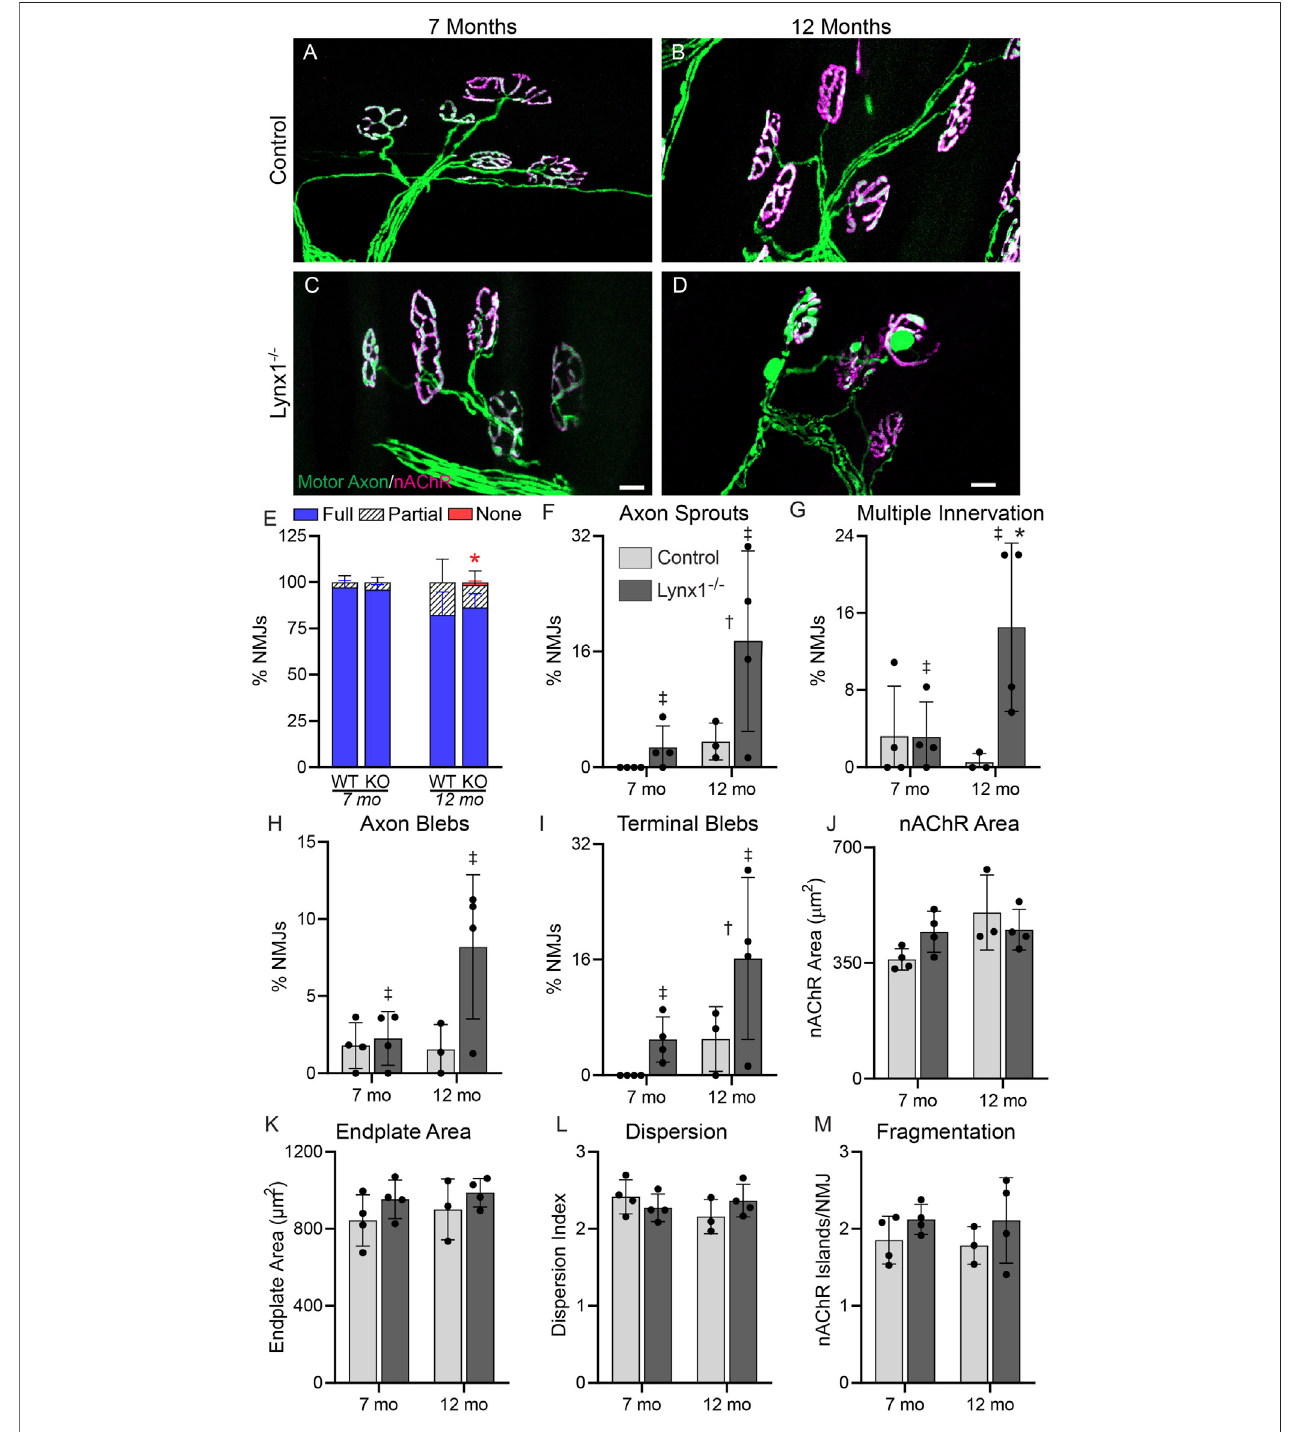
FIGURE 6 | Lynx1 deletion increases the incidence of age-related changes at adult NMJs. (A,B) Representative images of neuromuscular junctions (NMJs) in the extensor digitorum longus (EDL) of 7-month-old (A,C) and 12-month-old (B,D) control and Lynx1 − / − mice. Motor axons were labeled with YFP (green), and nicotinic acetylcholine receptors (nAChRs) were labeled with fl uorescently conjugated α -bungarotoxin (fBTX, magenta). (E) The percentage of innervated NMJs, either fully, partially, or not at all. (F – M) Morphological analysis of NMJs, including (F) the presence of axon sprouts, (G) multiple innervations, (H) the presence of preterminal axon blebs, (I) the presence ofblebs in the axonterminal, (J) nAChR area, (K) endplate area, (L) nAChR cluster dispersion, and (M) nAChR fragmentation. n = 3 – 4. * p < 0.05 versus age-matched control; † age effect, p < 0.05; ‡ genotype effect, p < 0.05; two-way ANOVA with Š ídák ’ s multiple comparisons test. All values are mean ± SD. Scale bar = 20 µm.